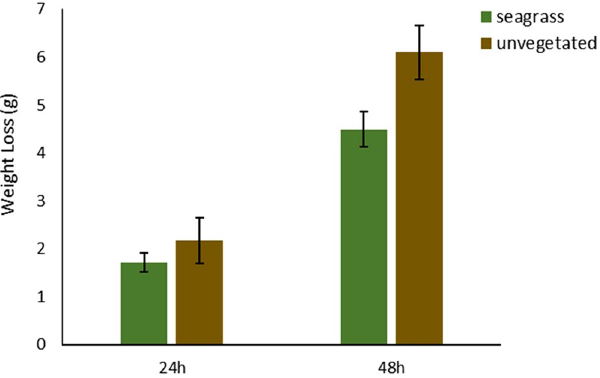
Figure 3. Weight loss of clod cards in seagrass and unvegetated plots after 24 h and 48 h (Error bars: 95% confidence